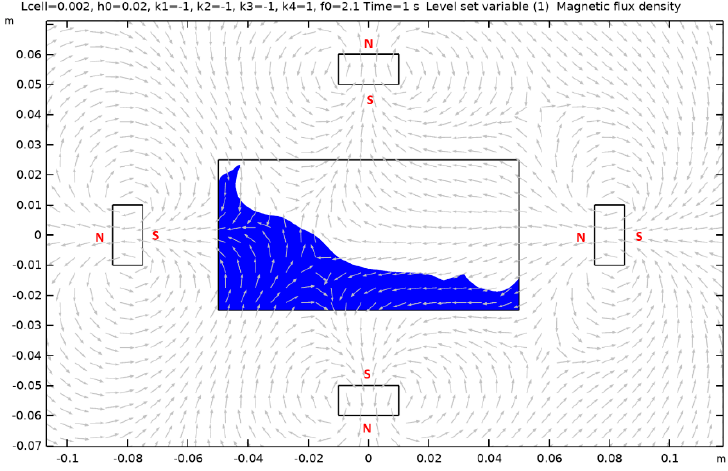
Figure A1. Case 2.